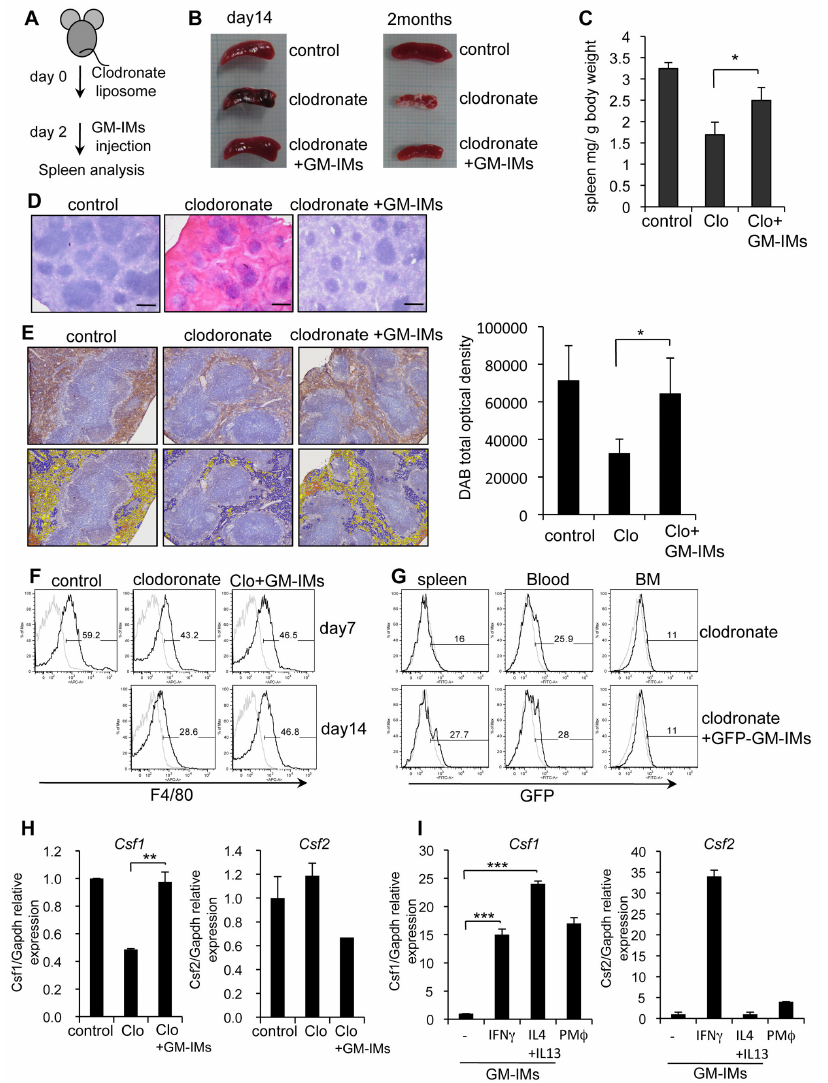
Figure 7. Effects of injection of GM-IMs to clodronate-liposome treated mice. (A) Schematic outline of clodronate-liposome and GM-IMs treatment. Two-month old female C57BL/6 mice were intravenously injected with clodronate liposomes. After two days, 5 x 10 6 GM-IMs were injected